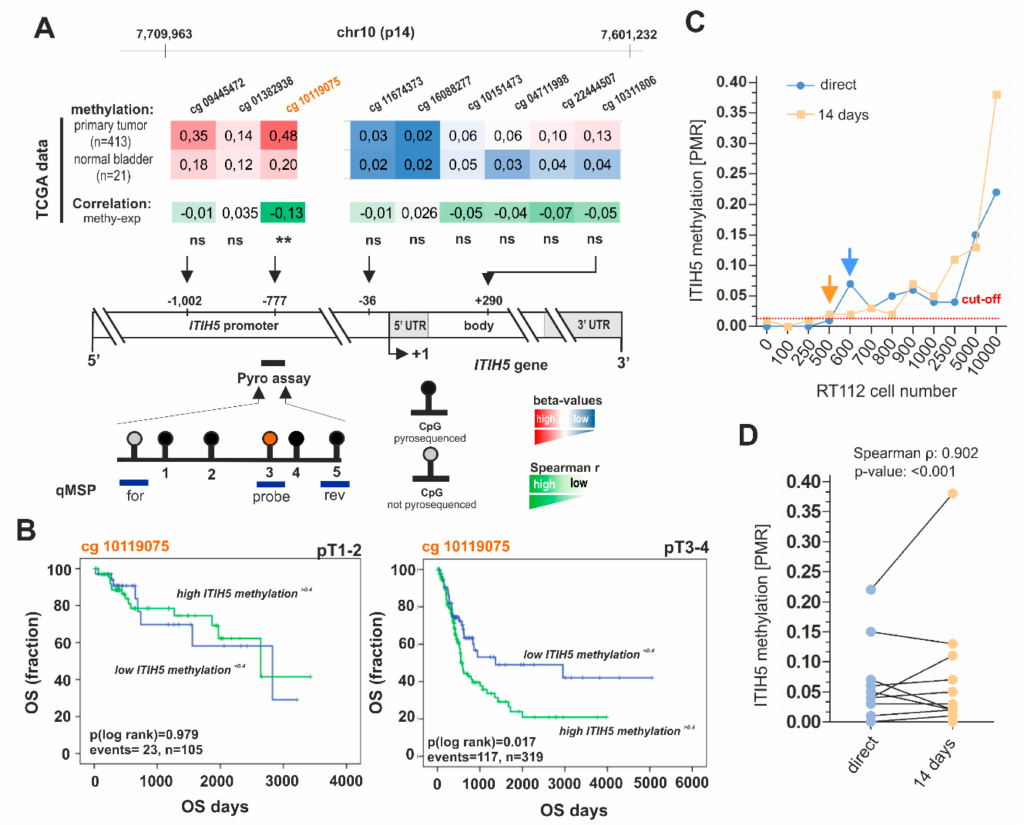
Figure 2. Analytical performance of the qMSP ITIH5 DNA methylation biomarker assay. ( A ) Schematic map of the human ITIH5 gene including the relative positions and median median β -values (of normal and tumor samples) of nine CpG sites based on 450K methylation arrays of the BLCA TCGA data set and corresponding Spearman correlation between ITIH5 methylation (colored scale bar red to white; red: high methylation, white: low methylation) and ITIH5 mRNA expression (colored scale bar green to white; green: strong correlation, white: no correlation) for each CpG site; ** p ≤ 0.01. + 1: ITIH5 transcription start site (TSS). Relative position of the upstream promoter area analyzed by bisulfite-pyrosequencing that comprises five single CpG sites (black dots) is shown as a black line. CpG sites analyzed by qMSP (blue lines) were indicated largely covering the pyrosequenced promoter region. ( B ) Kaplan–Meier survival curves display overall survival (OS) of patients with high ITIH5 methylation ( β -value of CG #10119075 > 0.4, green curve) compared to low ITIH5 methylation ( β -value of CG #10119075 ≤ 0.4, blue curve) based on TCGA data. ( C ) ITIH5 promoter methylation determined by using qMSP of spiked urine samples. Red dotted line: threshold value for positive detection; orange and blue arrow: stably exceeding the threshold (detection limit) ( D ) Correlation of ITIH5 DNA methylation for spiked urine samples of probe set A and